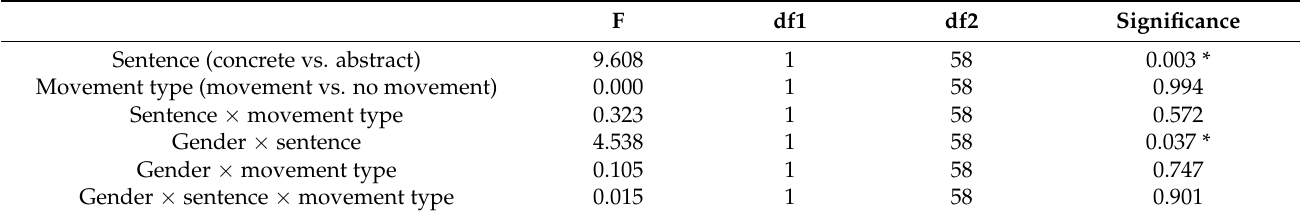
Table 3. Results of a 2 × 2 repeated measures ANOVA for response errors with gender as covariate. * = p < 0.05. F df1 df2